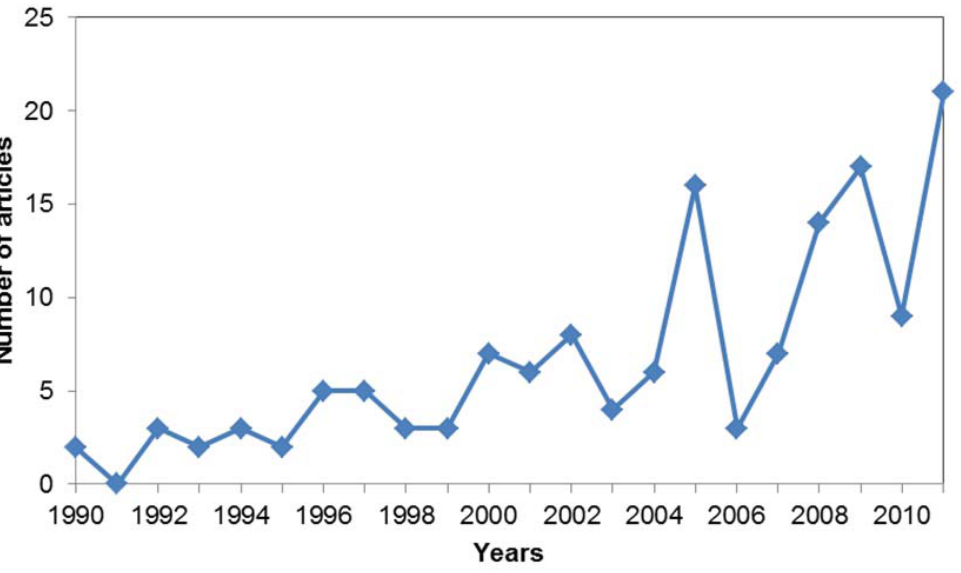
Figure 4. The number of reviewed articles containing positive keywords, published between 1990 and